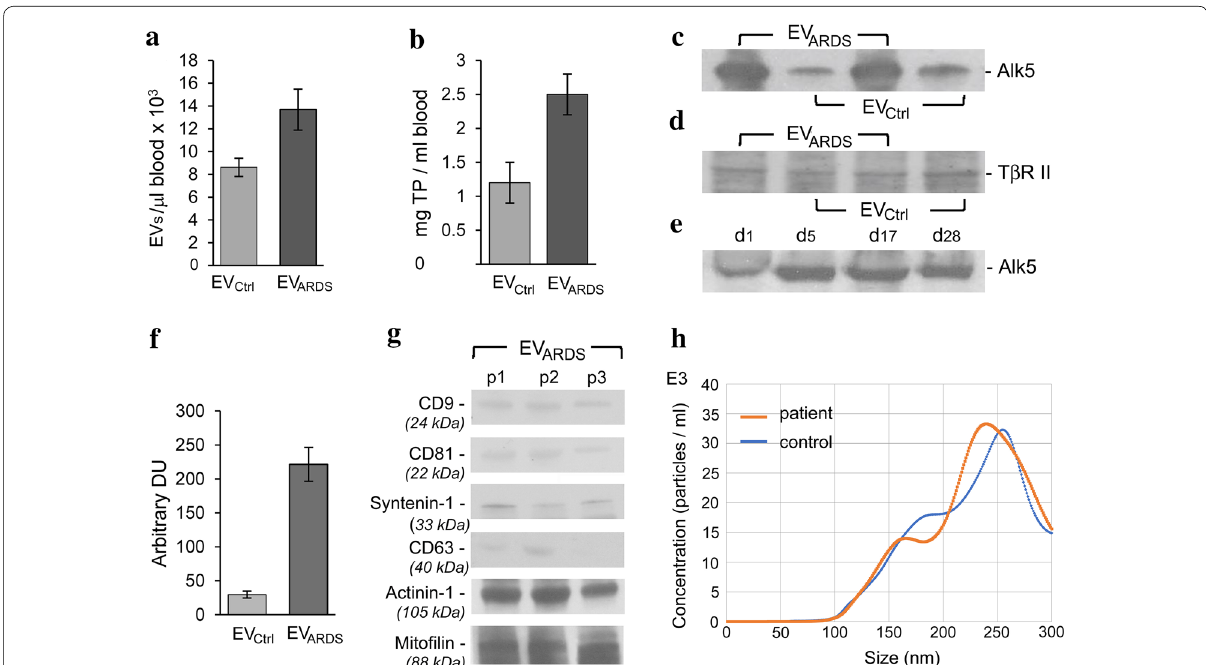
Fig. 2 ARDS subjects show increased counts of circulatory EV ARDS immunoreactive to TβRI/Alk5. a The mean count for EVs isolated from the blood of the ARDS patients (EV ARDS ) was 13,680 1811, with a range 11,000–17,500; Nine EV ARDS preparations from nine different ARDS patients were ± used. The EV Ctrl mean count indicated 8615 768, with a range 7700–9200; three preparations from the blood of three different control subjects ± were used. Data are normalized per 1 μl blood. Three independent experiments were performed. b Amount of total protein in the EV ARDS pellet and EV Ctrl pellet, normalized to 1 ml blood. Data are plotted as mean SD; *p < 0.05 vs. controls. c , d WB of Alk5 and TβRII protein expression in two ± EV ARDS and two EV Ctrl lysates, normalized to equivalent μl blood; n 9. Actin cannot be used as loading control, as there is no evidence that the = EVs contain actin. e Time course analysis of Alk5 in EV ARDS in one of the above ARDS cases; n 3. Day 1 is first day in ICU. f Densitometric analysis of = Alk5 protein expression in the EV Ctrl and EV ARDS lysates. Data are plotted as mean SD; *p < 0.05 vs. controls. g Size distribution and concentration of ± exosomes and smaller than 300 nm diameter microparticles in the isolated EV Ctrl and EV ARDS preparations, measured by NTA; n 3. h Representative = WB analyses of EV ARDS fractions of three different patients using Abs specific for CD9, CD81, syntenin-1, CD63, actinin-1 and mitofilin. Actinin-1 and mitofilin, considered specific markers for the non-exosomal microvesicles are enriched in the EV ARDS preparations; n =